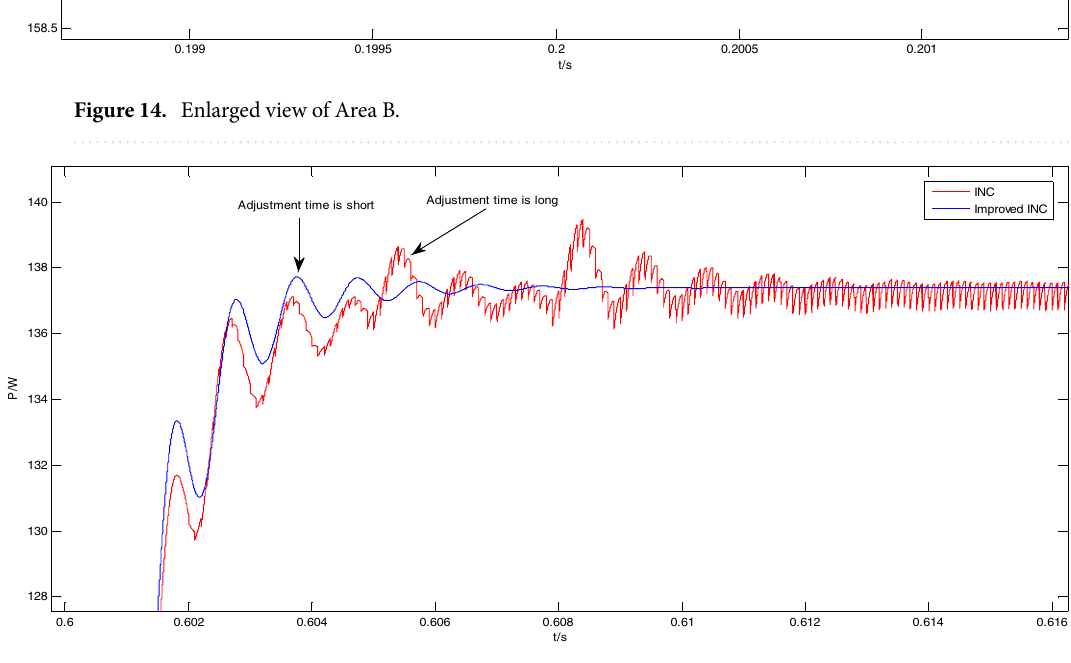
Figure 14. Enlarged view of Area B.